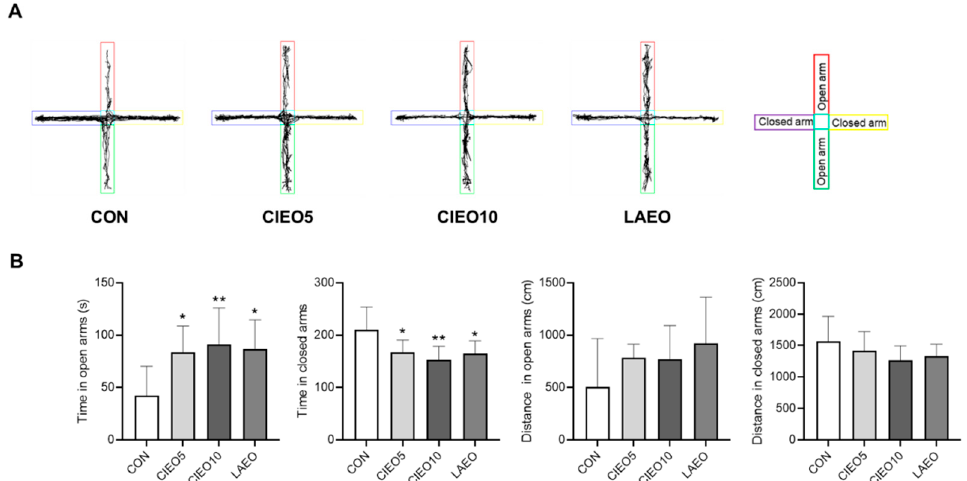
Figure 1. Effect of CIEO on anxiety-like behavior in mice. ( A ) Traveling paths in the EPM test. ( B ) The time and distance in the open arms and closed arms in the EPM were measured in a 5-min session. Data represent means ± SDs ( n = 8 per group). * p < 0.05, ** p < 0.01 vs. the CON group. CON: control; CIEO: cinnamon essential oil; LAEO: lavender essential oil.